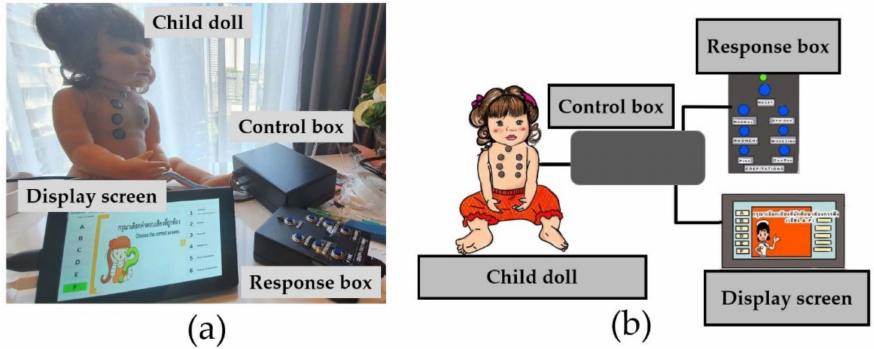
Figure 3. A CHIild Model (CHIM): ( a ) actual model and ( b )